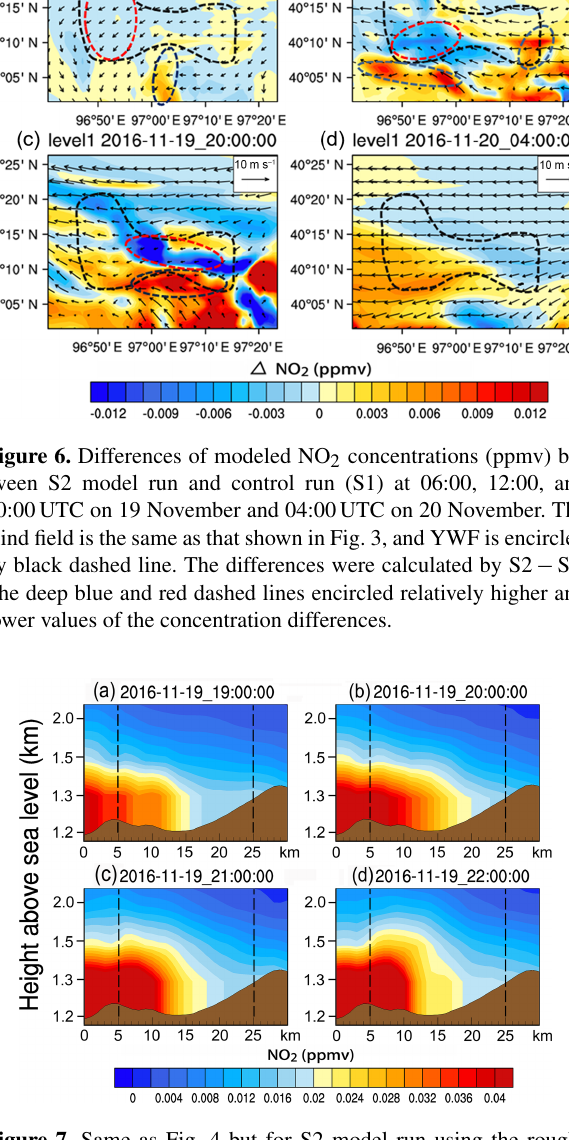
Figure 7. Same as Fig. 4 but for S2 model run using the rough- ness change parameterization scheme. The wind farm is bounded by black dashed